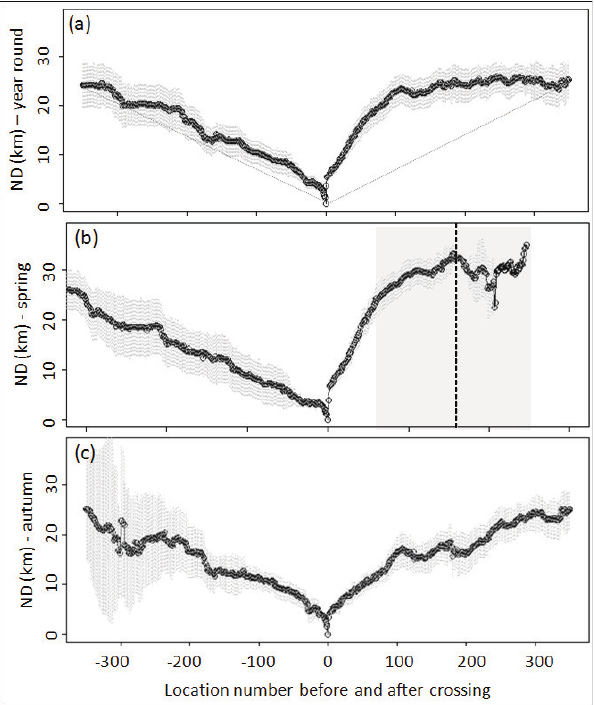
Fig. 5. Average Net Displacement (ND, km), which illustrates the speed of the movements towards and away from the road, calculated from the crossing point (coded 0) during 350 locations (ca. 45 days) before and after the crossing of road Rv 45 during both spring and autumn migration (a), and separately during spring (b) and autumn (c); dashed bars indicate standard errors. The dotted line in (a) indicates a theoretical ND if rein- deer moved between the summer and winter areas at a constant speed (i.e., if the presence of the road had no effect on the spatial behavior during migration). The shaded area and the dashed line in (b) indicate, respec- tively, the estimated calving range and average estimat- ed calving